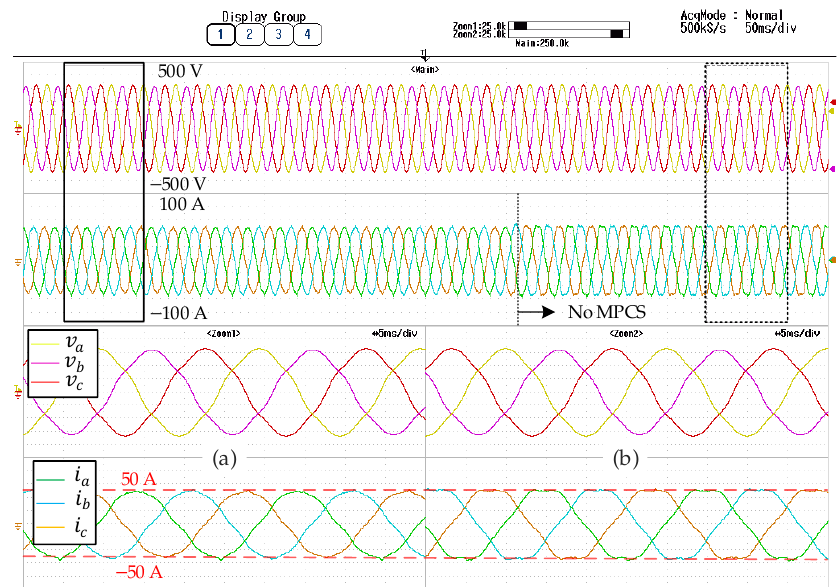
Figure 11. Experimental results delivering capacitive reactive power. Lowpass filter with a cutoff frequency of 1.5 kHz has been applied. ( a ) Zoom in voltage and current at the PCC when MPCS was operating; ( b ) Zoom in voltage and current at the PCC when MPCS was not operating.